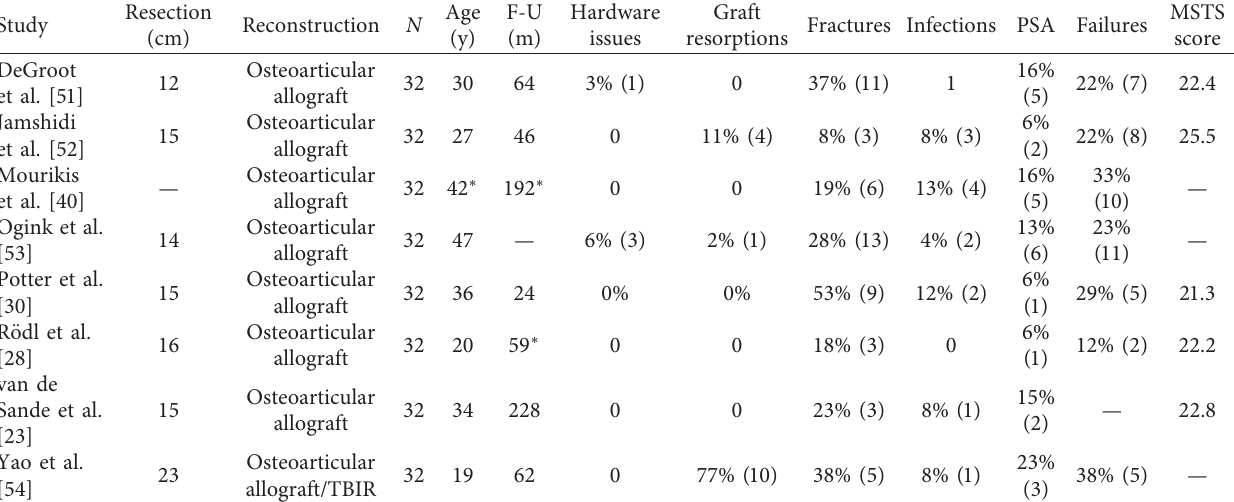
Table 1: Summary data for allograft